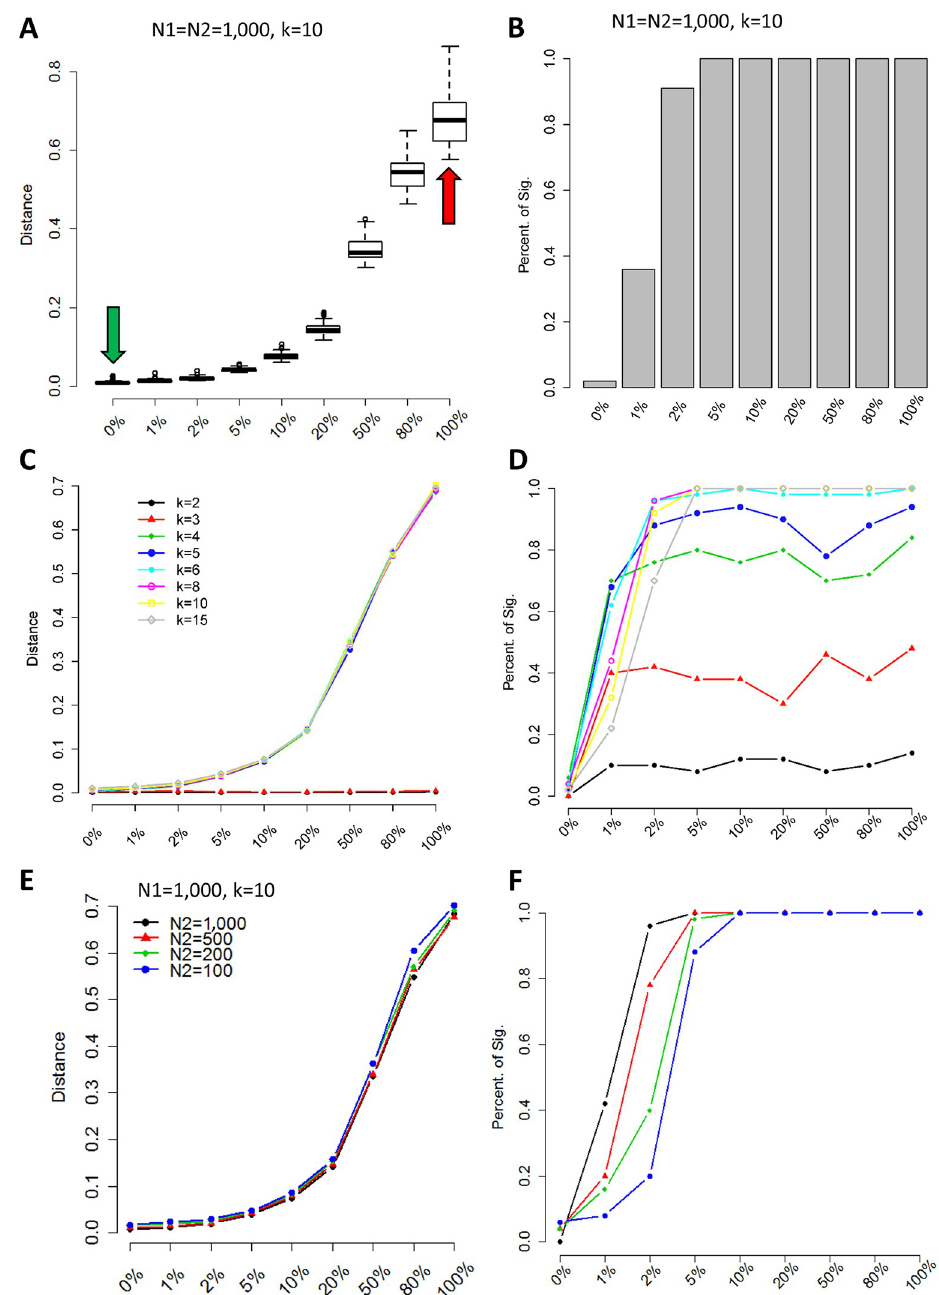
Fig 2. Simulation data reveal sc-UniFrac to be sensitive and robust. (A) Two groups (N1 and N2) of 1,000 cells were selected from CD8 and CD4 cells identified in the Wishbone dataset (S1 Data) [25]. N1 is always composed of 100% CD8 cells, while N2 is composed of CD8 cells and different proportions of CD4 cells (indicated on x-axis). Green and red arrows represent CD8/CD8 (completely similar) and CD8/CD4 (completely dissimilar) comparisons, respectively; y-axis is the sc-UniFrac distance calculated over n = 50 runs with k = 10. Boxes represent the first and third quartiles, and bars represent maximum and minimum values. (B) Sensitivity of sc-UniFrac evaluated by the fraction of incidences that a statistically significant sc-UniFrac distance was returned over n = 50 runs, as a function of increasing dissimilarity between N1 and N2 using the same simulation scheme as panel A. (C) Mean sc-UniFrac plotted as in panel A with varying k parameter. (D) Fraction significant sc-UniFrac detected plotted as in panel B with varying k parameter. (E) Mean sc-UniFrac plotted as in panel A with N1 = 1,000 but a varying N2 size to determine the effect of dataset size imbalance on sc-UniFrac. (F) Fraction significant sc-UniFrac detected plotted as in panel B with N1 = 1,000 and varying N2 size.